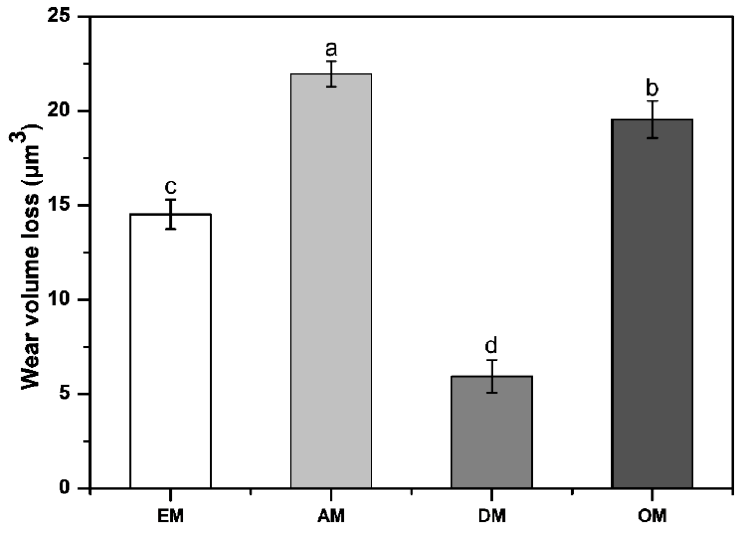
Figure 9. Comparison of wear volume loss for each group after the wear test. Differences in lower- case alphabetical letters above the bar graph indicate significant differences among the groups ( p < 0.05).